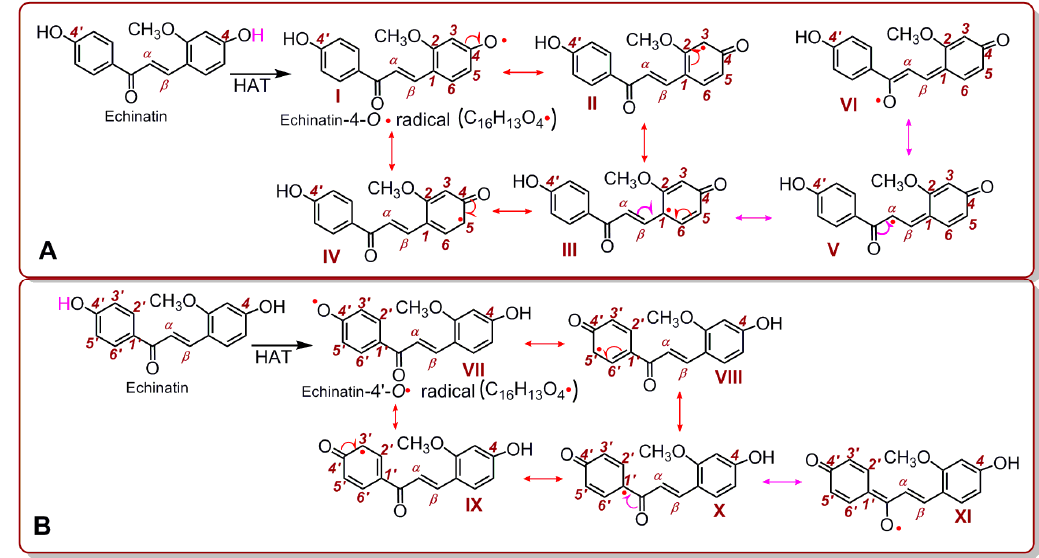
(cid:48) -O • radical ( B ).